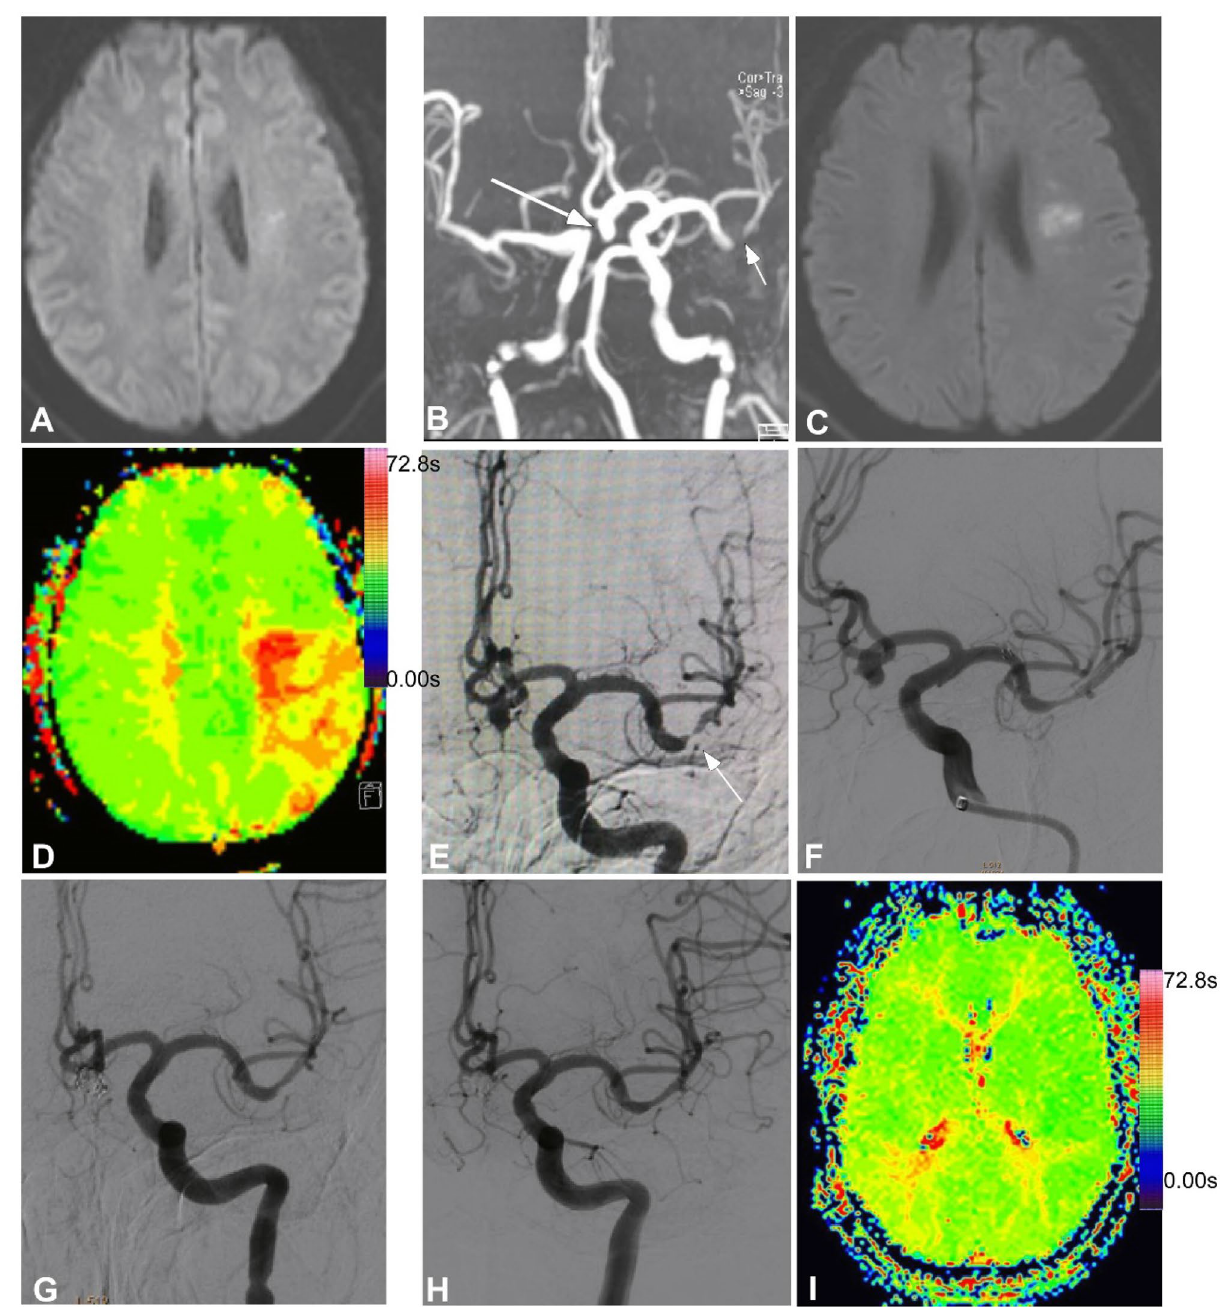
Figure 3. Severe stenosis in the lower trunk of the left middle cerebral artery (MCA). ( A ) Magnetic resonance imaging (MRI) showed bead-like high intensity lesion near the ventricular body. ( B ) MRI angiography revealed severe stenosis in the lower trunk of the left MCA (small arrow) and an aneurysm (large arrow) at the anterior communicating artery. ( C ) Nine days after admission, the symptoms were aggravated and the second MRI scan demonstrated increased infarction area. ( D ) Perfusion imaging showed that greater time is needed for the blood flow to reach the left parietal occipital lobe. E&F. Digital subtraction angiography demonstrated severe stenosis in the lower trunk of the left MCA (arrow, E ), and stent angioplasty was performed with an Enterprise stent to relieve the stenosis ( F ). G . Endovascular coil embolization was performed to completely occlude the anterior communicating aneurysm. ( H ). Follow-up angiography at six months following stenting revealed patent flow in the lower trunk of the left MCA. ( I ). Perfusion imaging showed the time is significantly improved for the blood flow to reach the left parietal occipital